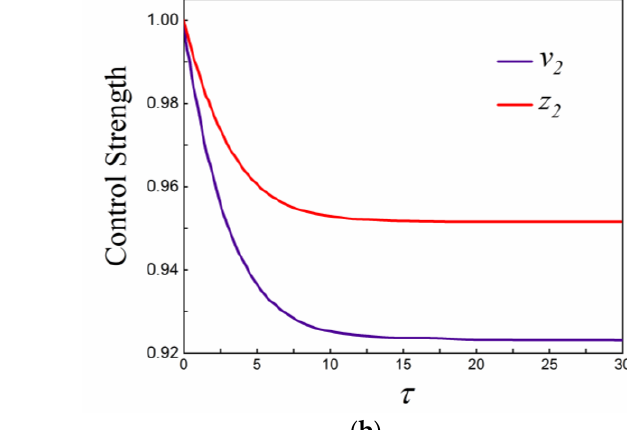
Figure 16. Master ( v , x )—black color, and master–slave ( v , v 1 )—purple color phase portraits.